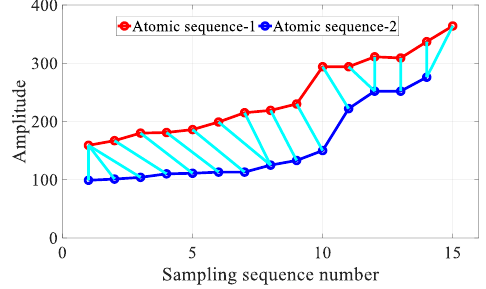
Figure 11. Atomic sequence matching using DTW.